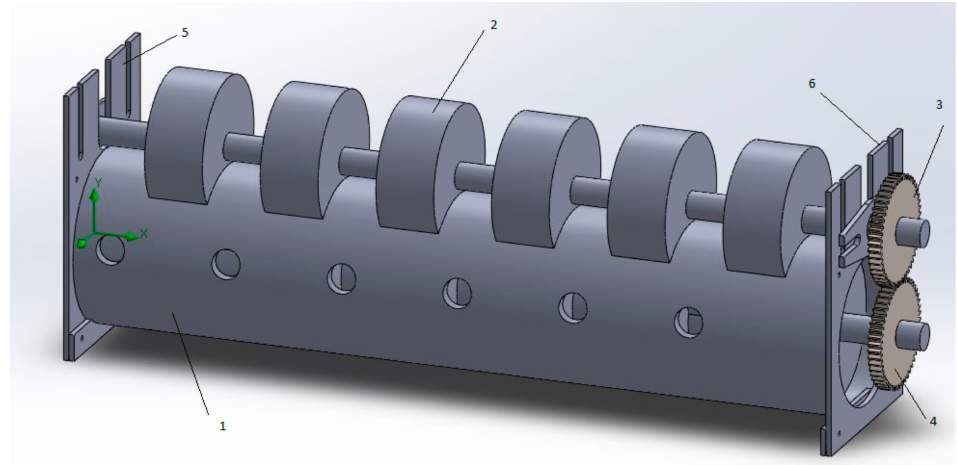
Figure 17. General view of the volume-sectional hydraulic